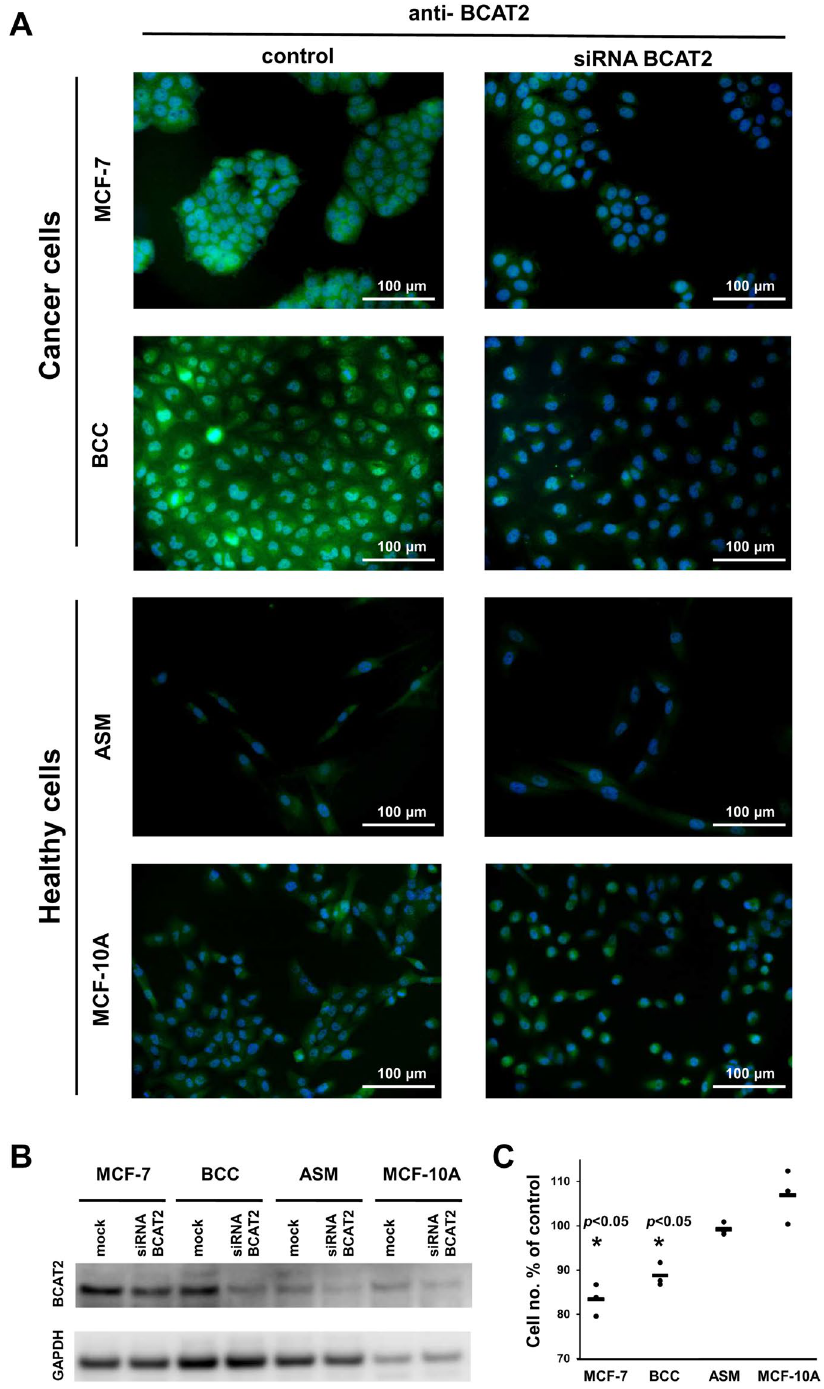
Figure 6. The effect of BCAT2 silencing on proliferation of breast cancer and normal cells. ( A ) Immunofluorescence of BCAT2 in cancer (MCF-7 and BCC) and normal (ASM and MCF-10A) cells in control and after BCAT2 siRNA transfection (green-secondary antibody to rabbit IgG-H&L conjugated with Alexa Fluor 488; blue-DAPI stained nucleus). ( B ) Representative Western blot showing BCAT2 expression levels after BCAT2 siRNA transfection compared to mock-treated controls. ( C ) Inhibition of cancer cell (MCF-7 and BCC) proliferation after BCAT2 silencing determined by flow cytometry assay. Data are expressed as a percentage of mock-treated controls (n = 3). All experiments were performed 24 h